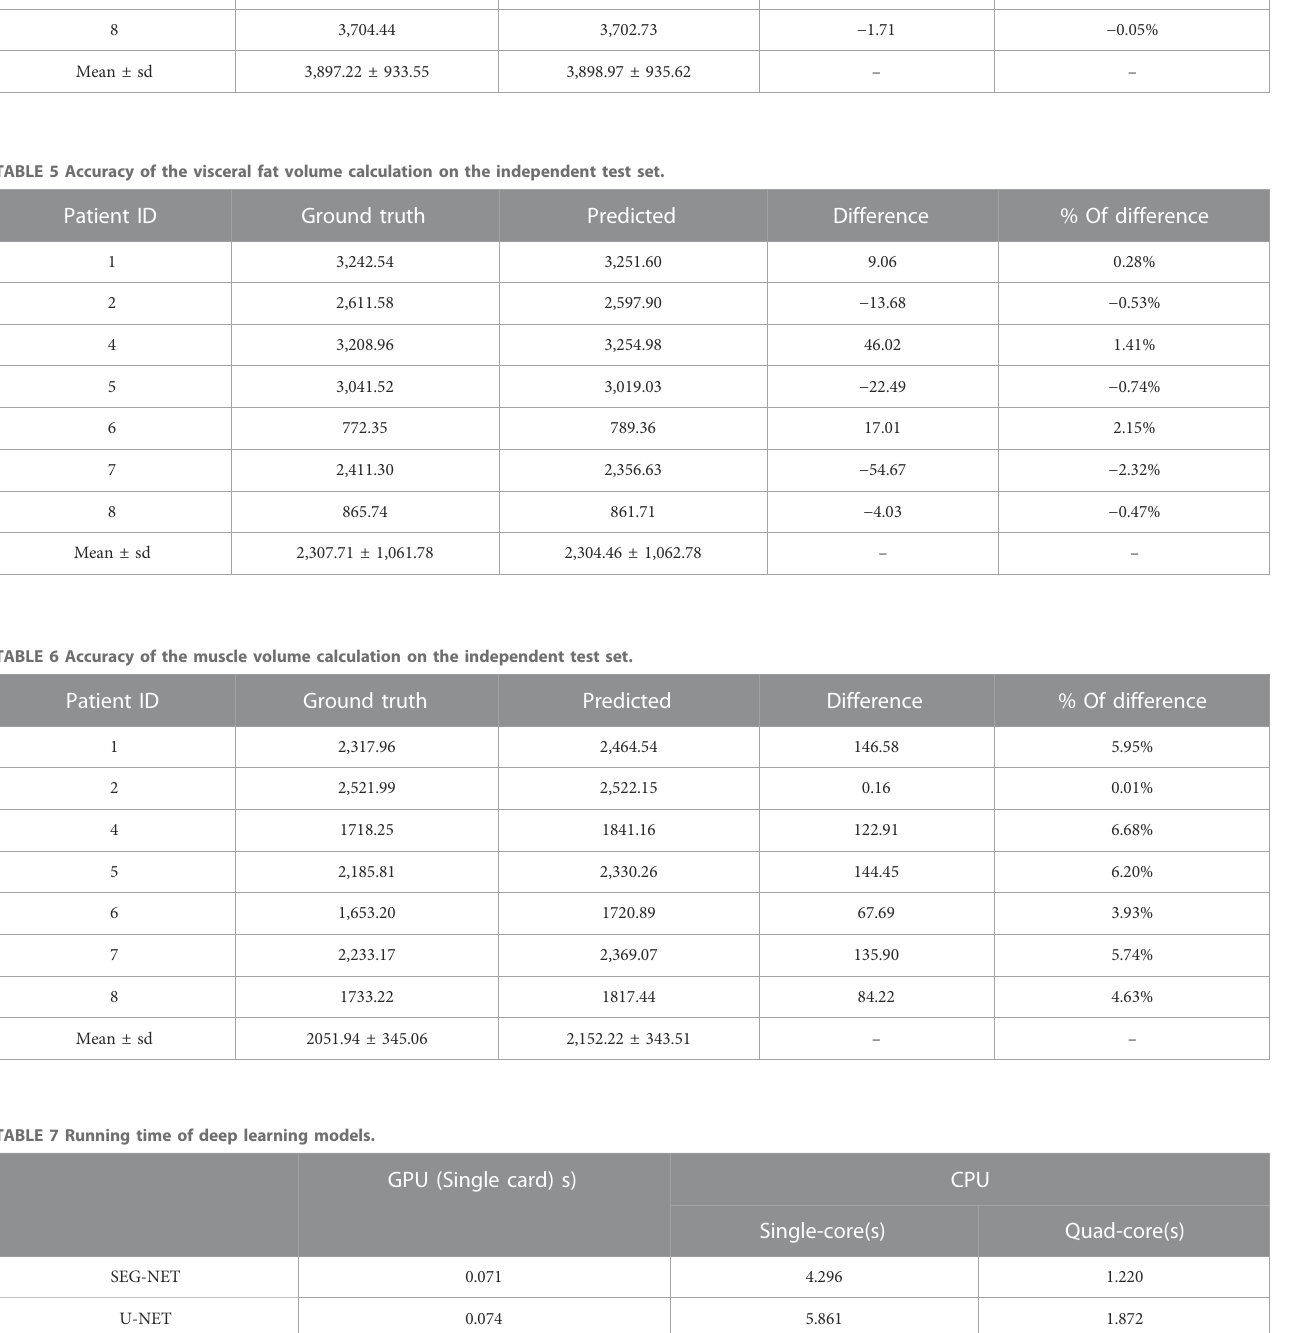
TABLE 5 Accuracy of the visceral fat volume calculation on the independent test set.